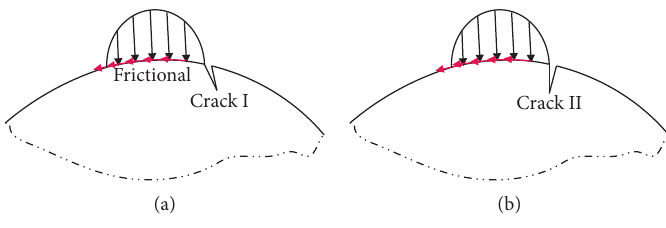
Figure 6: Stress process on crack surface: (a) crack I; (b) crack II.